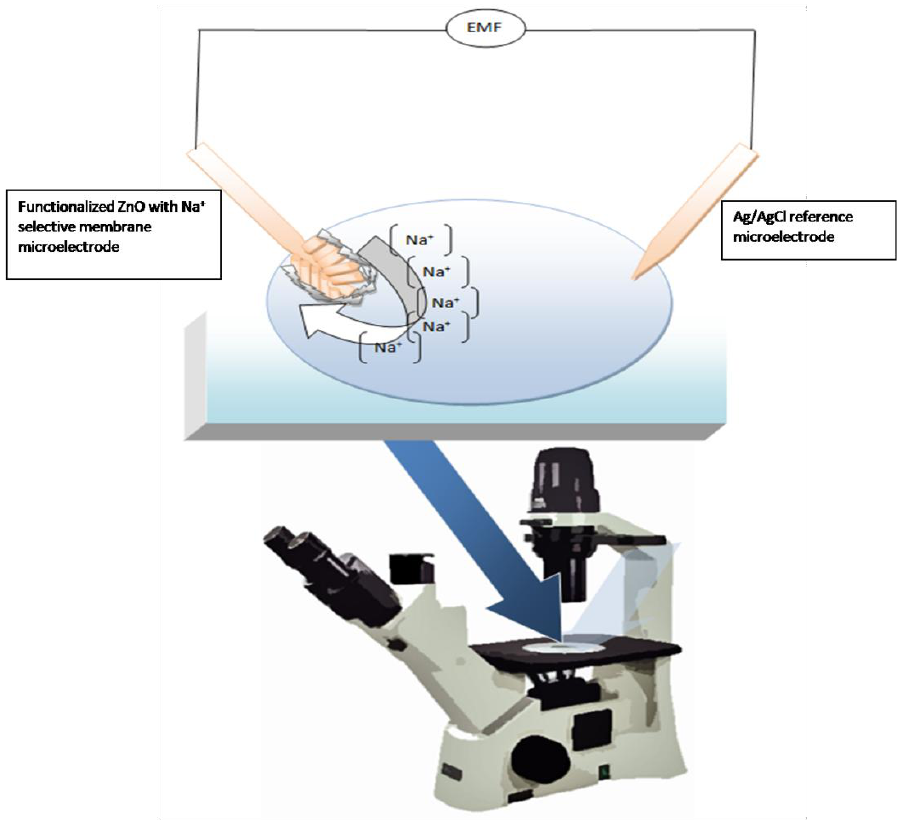
Figure 3. Schematic diagram illustrating the setup for the measurement of the intracellular Na +